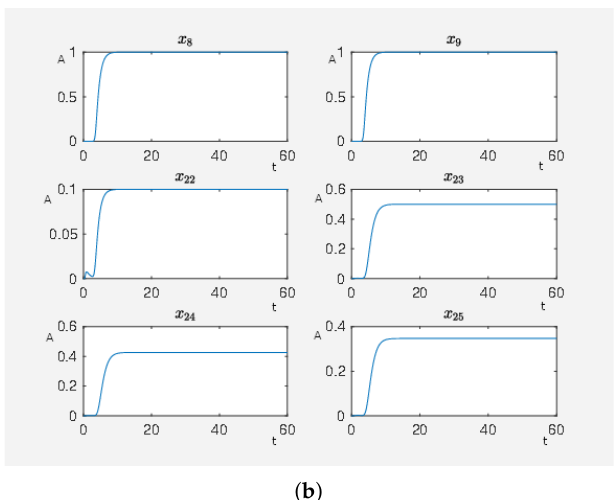
Figure 14. Activity levels for a concentration of three times phosphorylated ERK1/2 at 10% of its maximum concentration. ( a ) Time curve of external stimuli where u 3 inhibits ERK1/2 dim 3P, u 6 activates angiotensin II. On the abscissa, we have the time (t) and on the ordinate the activity level (A). ( b ) Time curve of x 8 the activity level of p90RSK, x 9 the activity level of p70S6K, x 22 activity level of ERK1/2 dim 3P, x 23 the activity level of Elk1, x 24 the activity level of MSK1 and x 25 the activity level